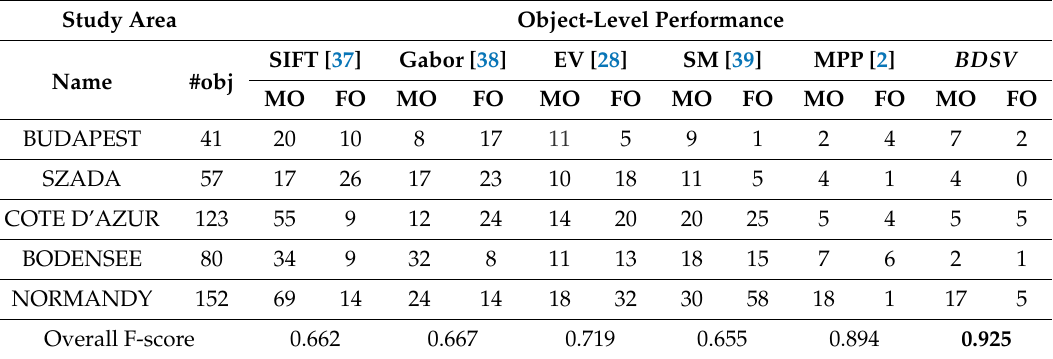
Table 3. Object-level accuracy assessment of benchmarked algorithms over the SztaKi–Inria dataset. MO: missing objects; FO: false objects.